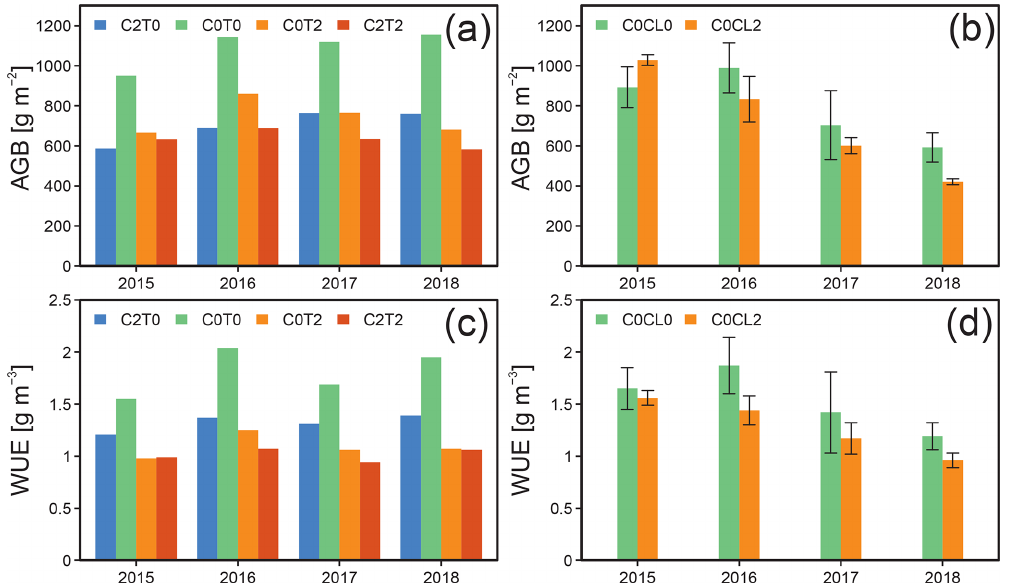
Figure 3. Dry aboveground biomass (AGB) during the observational periods of 2015–2018 for the manipulative approach of Lysi-T-FACE (C2T0, C0T0, C0T2, and C2T2) (a) and observational approach of TERENO-SOILCan (Rollesbroich – C0CL0; Selhausen – C0CL2) (b) , as well as the crop water use efficiency (WUE), for the manipulative (c) and observational approach (d) .